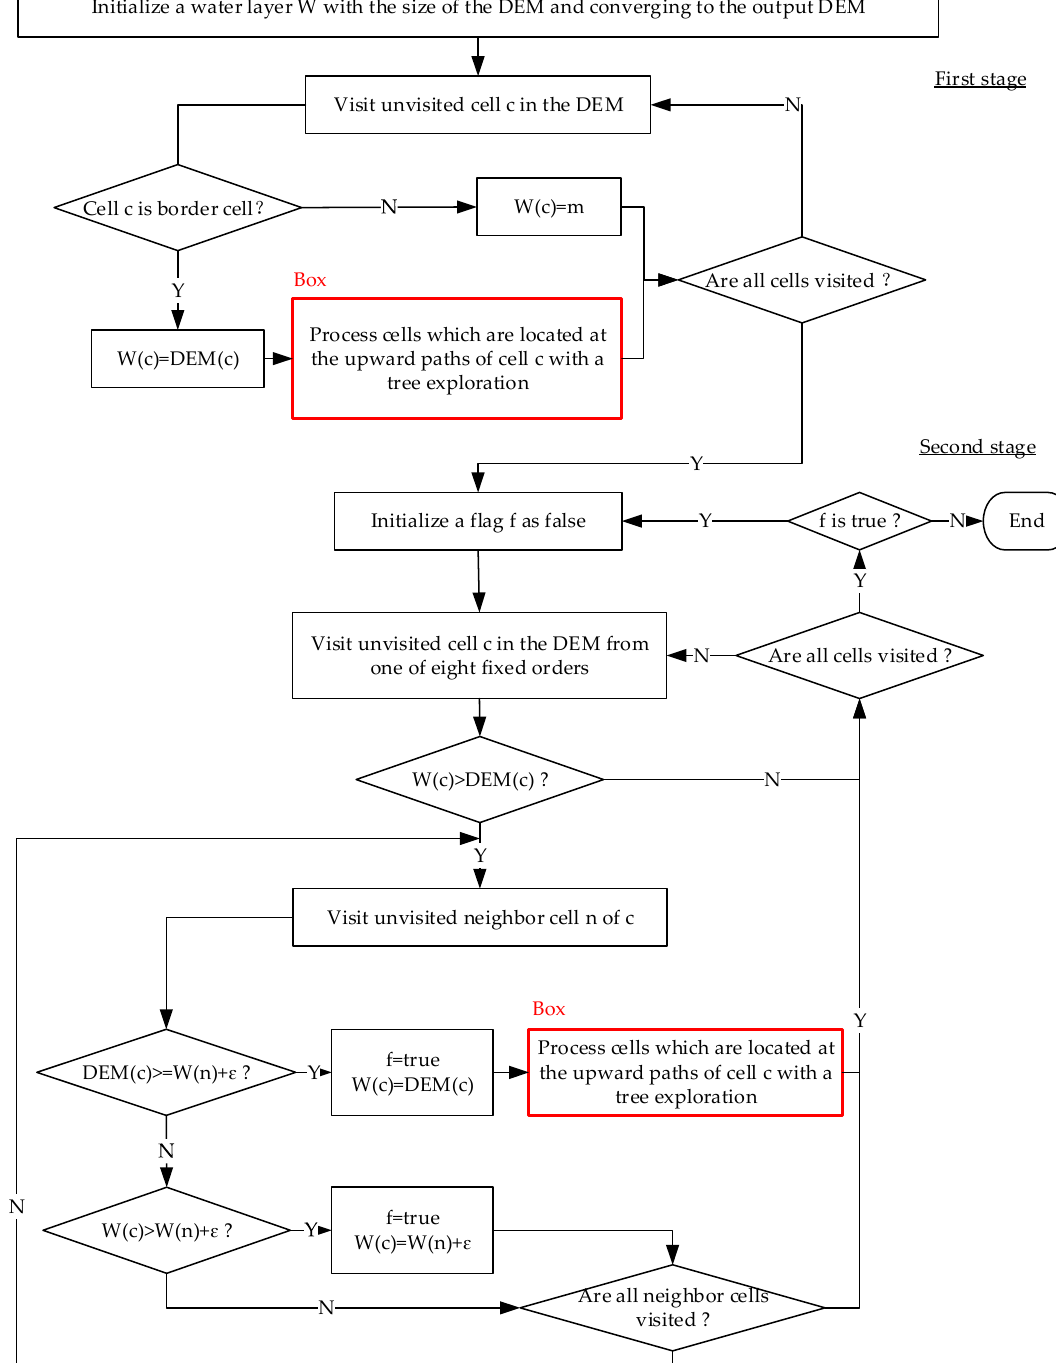
Figure 1. The flowchart of the improved implementation of the P&D algorithm. A tree exploration, shown in red box, is used to process cells which are located on the upward paths of a known cell. The W&T variant is proposed in Wallis et al. (2009) [20] and improved in Tarboton (2014) [21]. This variant avoids the repeated scanning of the entire DEM by using two stacks (S 1 and S 2 ) to hold all unknown cells. All unknown cells are pushed into S 1 on the first scan. On each subsequent scan, the cells are popped off the S 1 and pushed into S 2 if they do not become known cells. The two stacks